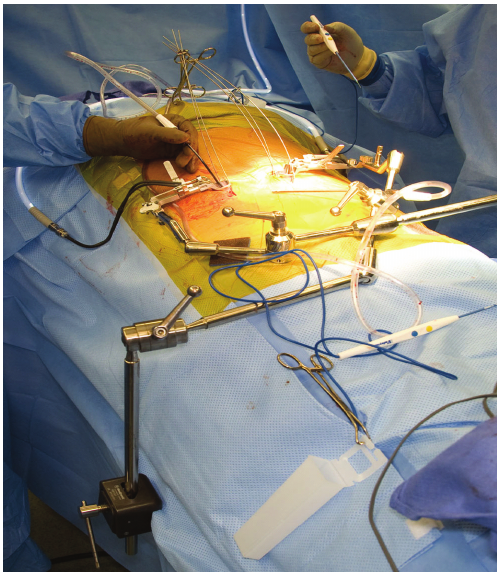
Figure 4: Setup for bilateral extracavitary approach showing dilat- ing retractors inserted o ff midline rigidly attached to the